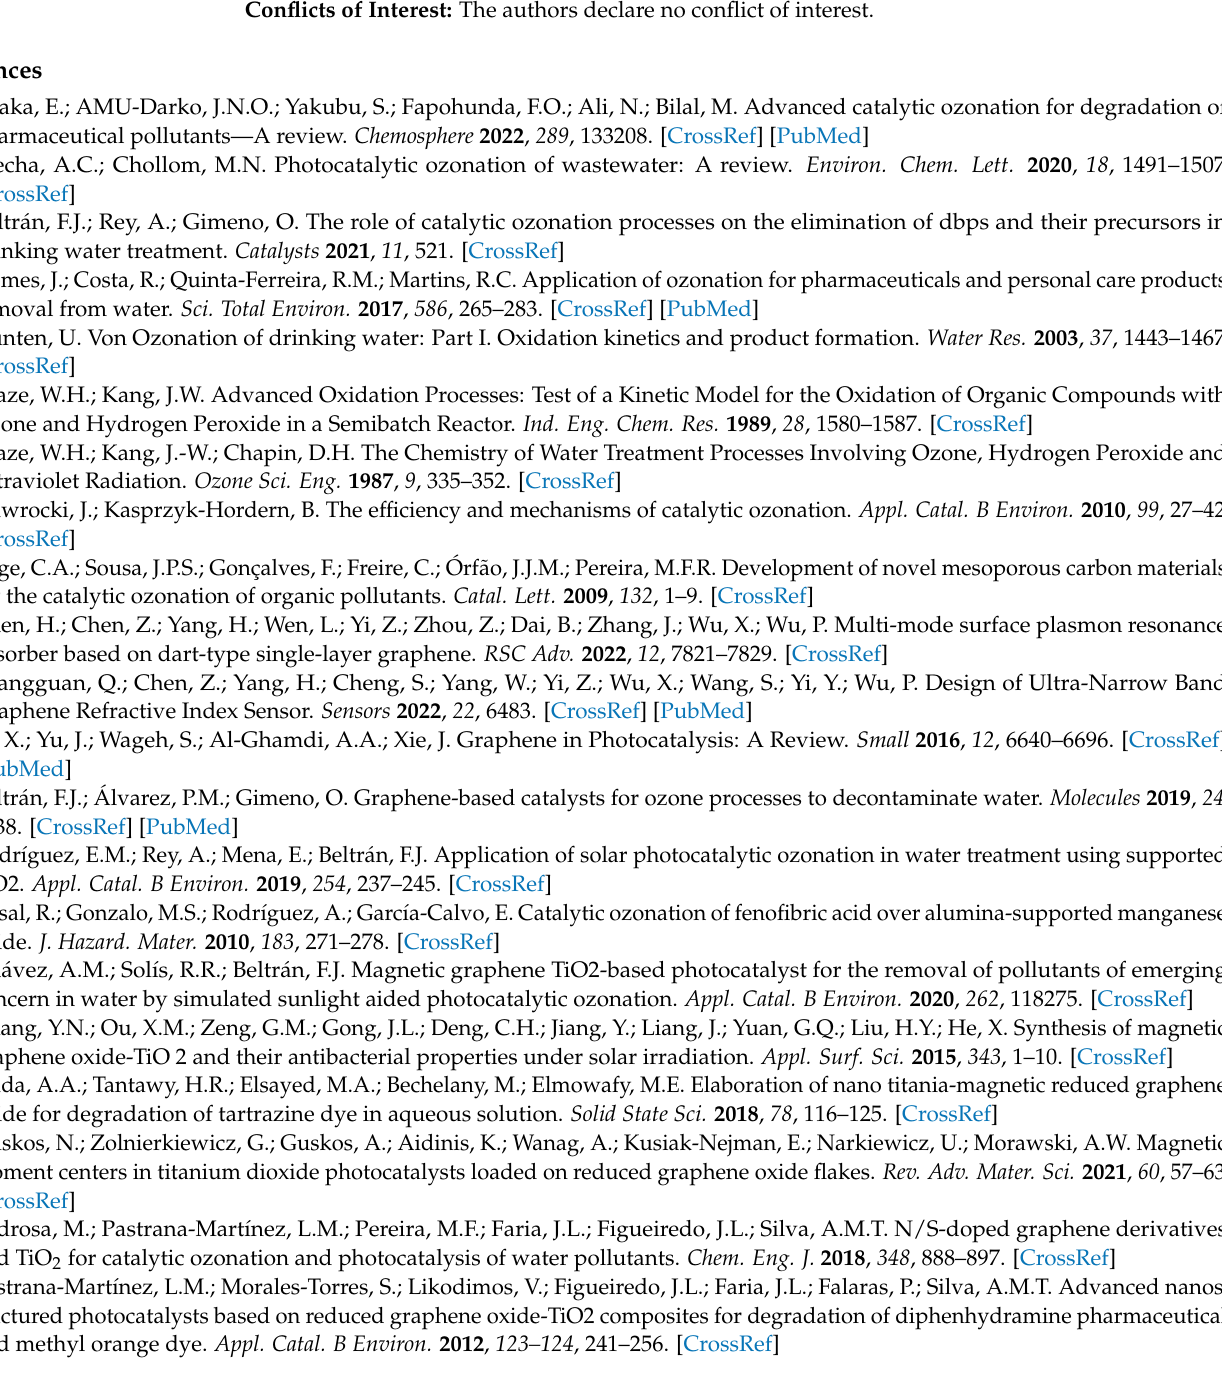
FeGoTi, Figure S11. Comparison of XRD pattern of fresh and used FeGOTi (A), TGA and MS detected for the recovered catalyst (B), Figure S12. Fe2p XPS of fresh (a) and four times reused (b) FeGOTi catalyst